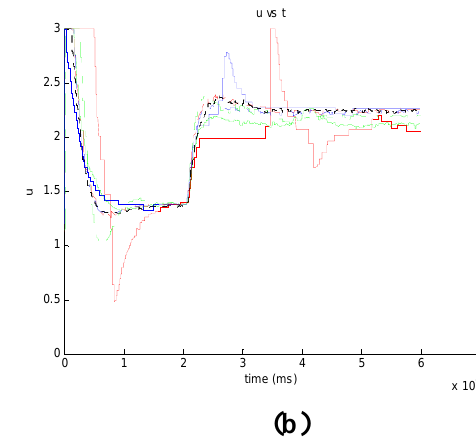
Figure 13. (a) System responses and (b) control action of the time-based (black), hybrid (red), LC (blue), ILC (green) , LP (dashed red), ILP (dashed blue), EN (dashed green) with disturbance.  = event